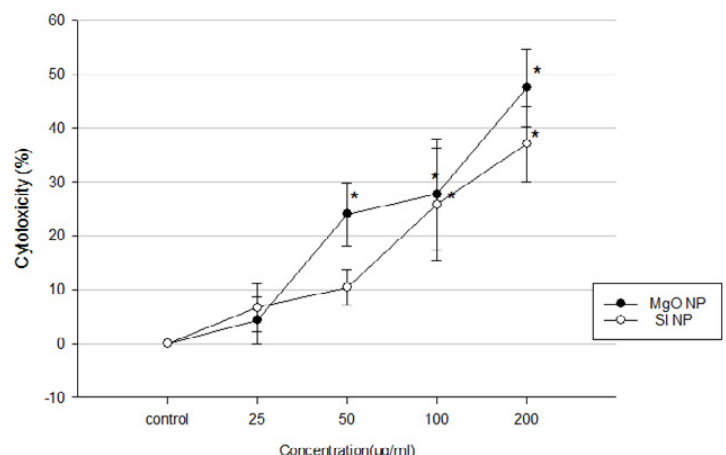
Fig. 3. Dose-dependent toxicity of SiO 2 and MgONPs in HepG2 cells which were treated with various concentrations of NPs for 24 h and the cytotoxicity was determined by the MTT assay. Values were the mean ± SD from three independent experiments. Significance is indicated by: *p < 0.05 versus the control cells.